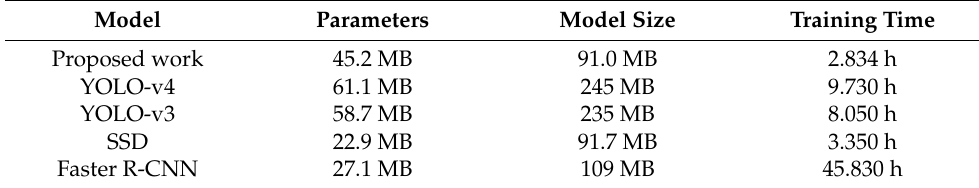
Table 5. Comparison of different models in parameters, model size, and training